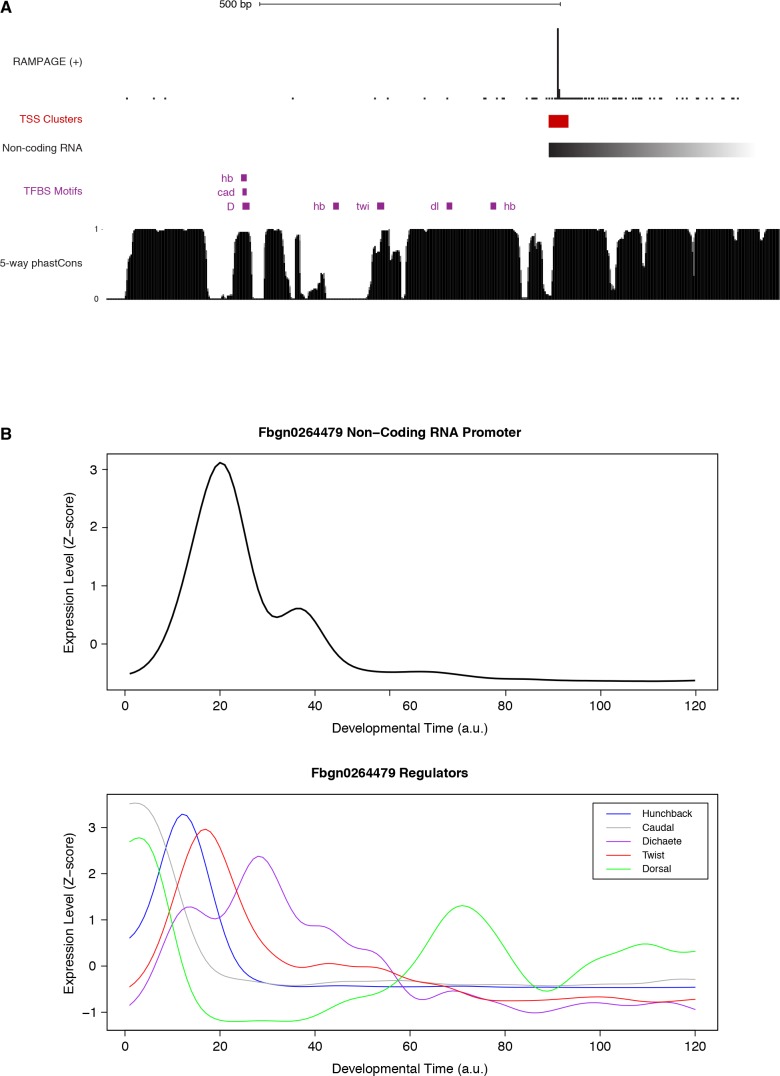
FBgn0264479 transcriptional regulation.(A) Sequence conservation over the putative binding sites for the factors with ChIP-chip signal over the promoter (see Suppl. Figure 18). We used FIMO to search for Jaspar-defined motifs within 600 bp upstream of the main TSS. Note that all putative TFBSs but one are under strong purifying selection within the melanogaster subgroup. (B) Expression profiles of the genes encoding the putative regulators of FBgn0264479.